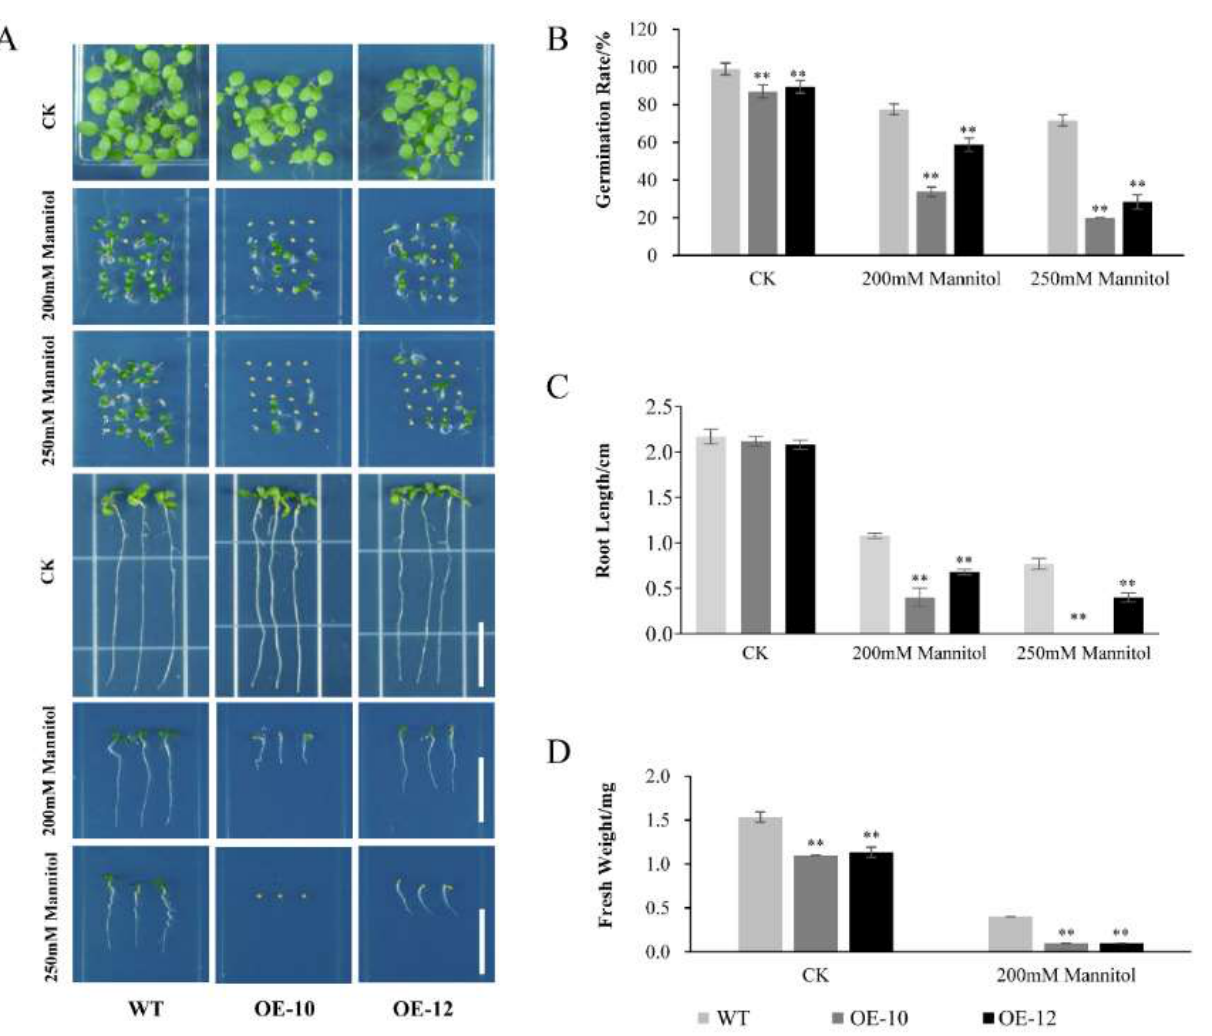
Figure 7. Phenotypic analysis of AcWRKY31 overexpression Arabidopsis plants in response to drought stress. ( A ) Performance of WT and AcWRKY31 overexpression Arabidopsis plants with or without drought treatment for 7 days; scale bar = 1 cm. The germination rate ( B ), root length ( C ) and fresh weight ( D ) of all lines in ( A ). Error bars indicate ± SD of three biological replicates. Asterisks indicate significant differences between the WT and the AcWRKY31 overexpression lines evaluated with Student’s t test (** p < 0.01).